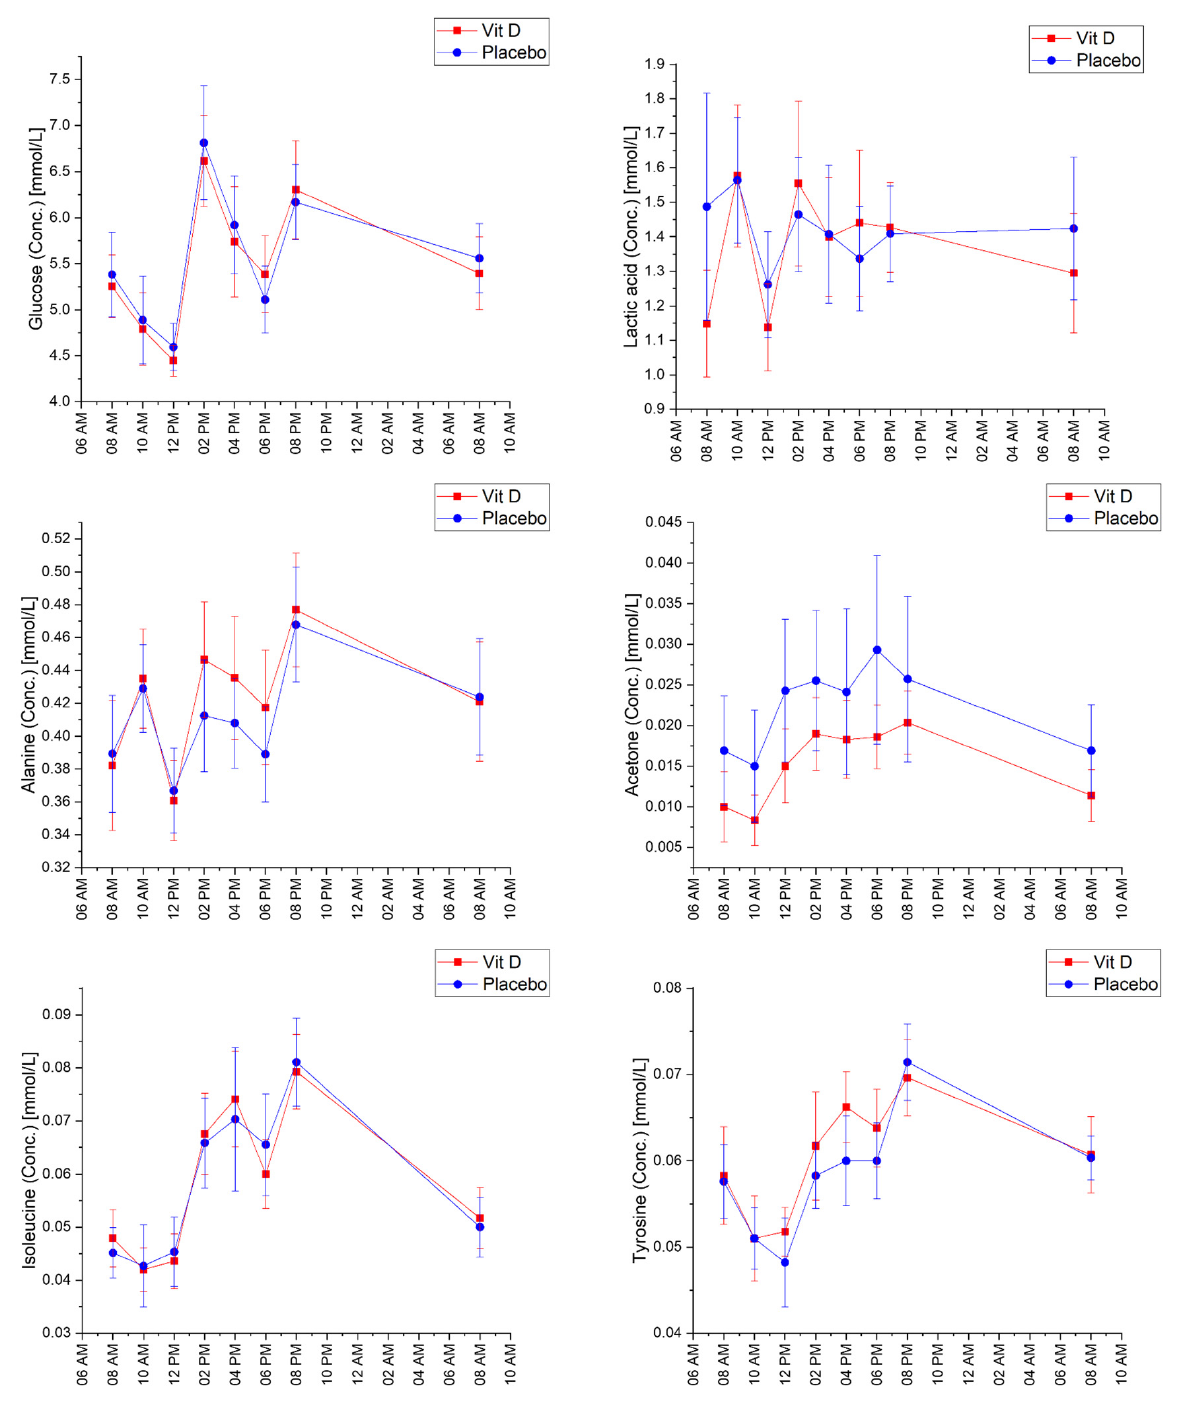
Figure 1. Concentrations in mM (Mean ± 95% CI) of plasma metabolites over time in participants after vitamin D 3 supplementation and placebo.